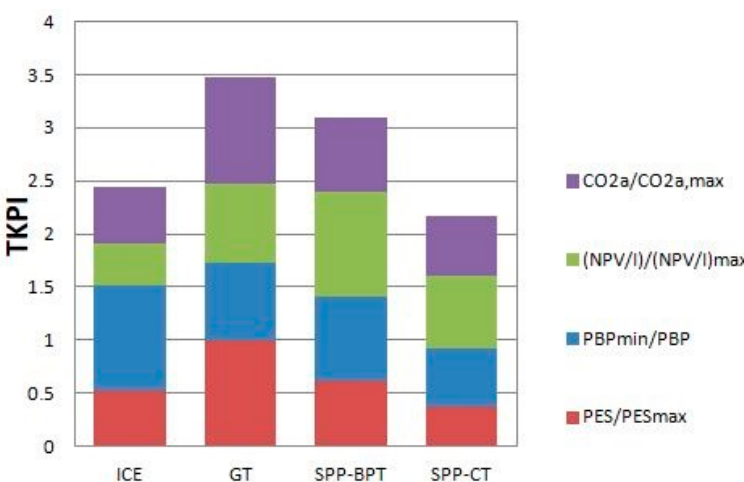
Figure 8. Total key performance indicator (TKPI) values and breakdown for the considered cogeneration technologies (optimal design).